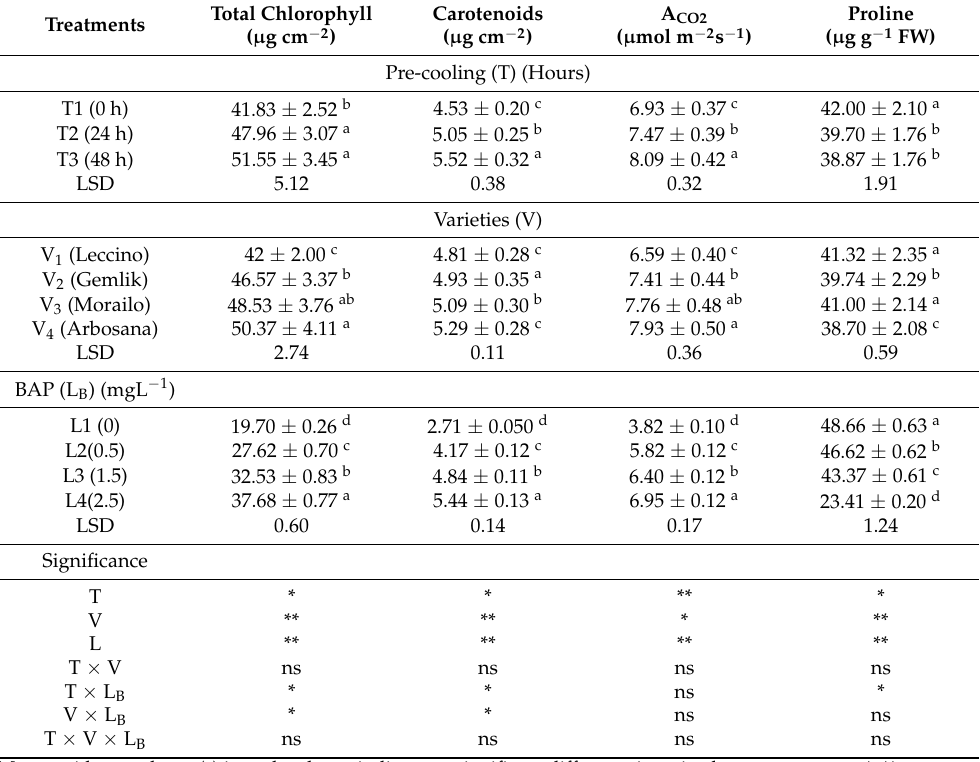
Table 2. Effect of different pre-cooling treatments and varying concentrations of BAP on physiological parameters of different olive ( Olea euorpea L.) genotypes cultured within micropropagation system using OM.